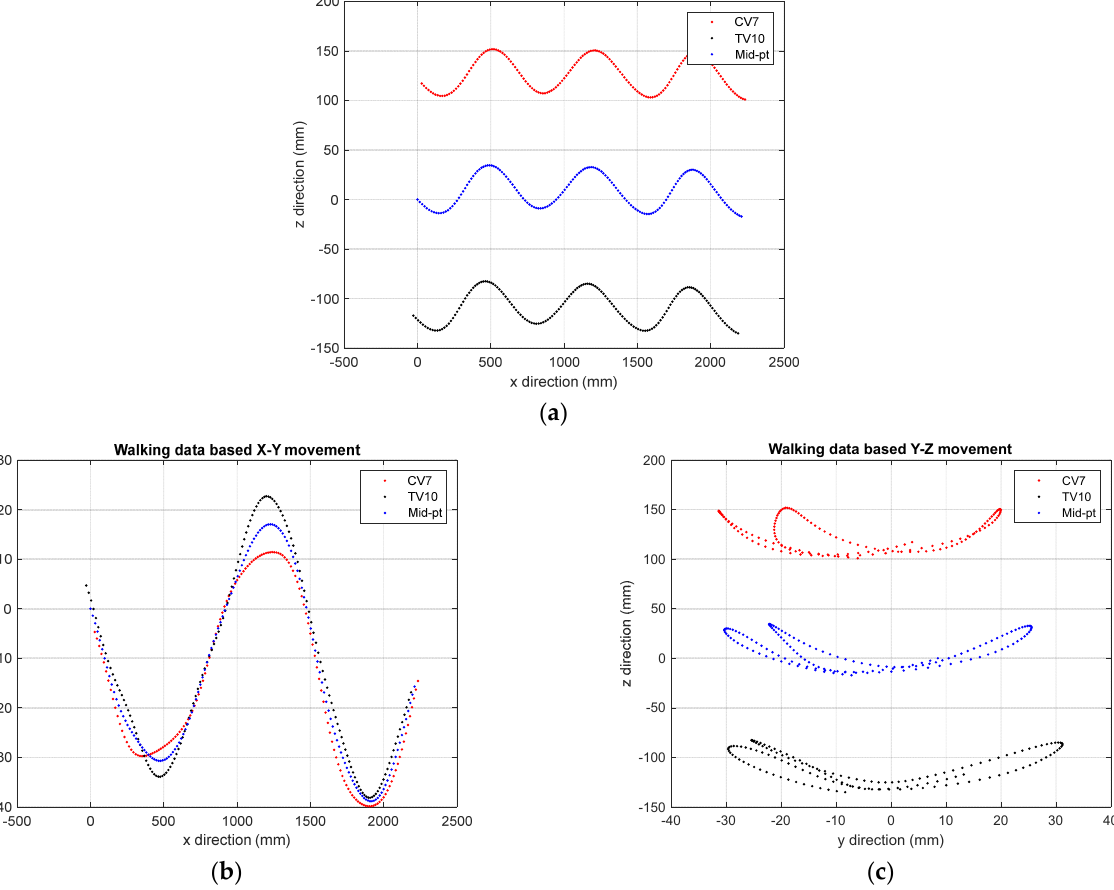
Figure 5. Analysis of marker movement according to straight walking: ( a ) X–Z directional movement; ( b ) X–Y directional movement; ( c ) Y–Z directional